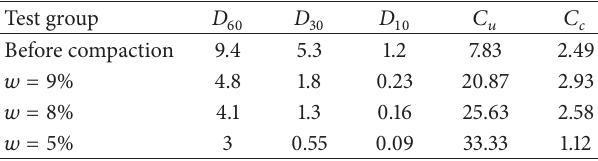
Table 2: Uniformity coefficient 𝐶 𝑢 and gradation coefficient 𝐶 𝑐 .